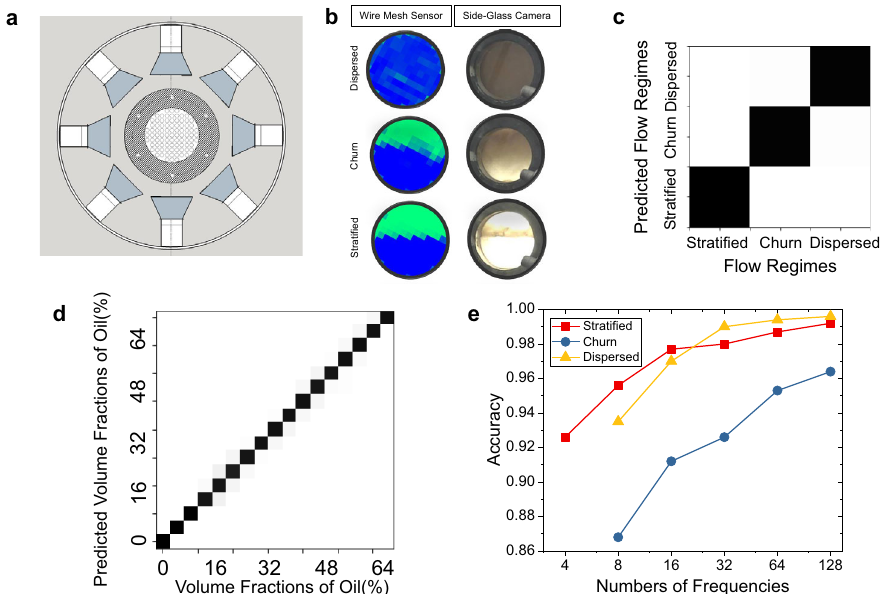
Fig. 4 Pilot-scale experiments and the machine learning predictions on fl uid phase fractions and fl ow regimes. a Cross-section view of the pilot-scale integrated device with photonic crystal surrounded by four pairs of ridged horn antennas. b Example of the various forms of fi eld-test data collected at 44% oil fraction: (left column) wire-mesh sensor and (right column) digital images from side-glass camera. This data are primarily used to con fi rm the fl ow regimes which is one of the data labels utilized in the machine learning algorithm. With respect to the wire-mesh data map, green pixels indicate oil and blue pixel indicate water. Top: dispersed fl ow regime achieved at an average fl ow rate of about 250 GPM (gallons per minute), Middle: churn fl ow regime achieved at an average fl ow rate of about 110 GPM; Bottom: strati fi ed fl ow regime achieved at an average fl ow rate of about 60 GPM. c The 2D probability histogram of predicted fl ow regimes (strati fi ed, churn, or dispersed) tested with Convolutional Neural Net and data from the fi eld test. The gray-scale color that indicates the probability of prediction is the same as that shown in Fig. 3a. d The 2D probability histogram of predicted oil fraction in the churn fl ow regime tested with Convolutional Neural Net and data from the fi eld test. The grey-scale color that indicates the probability of prediction is the same as that shown in Fig. 3a. e Oil fraction prediction accuracies of the CNN model utilizing data from the number of frequencies indicated on the x -axis for the three fl ow regimes tested in the fi eld. Red, yellow, and blue data points correspond to strati fi ed, churn, and dispersed fl ow regimes,